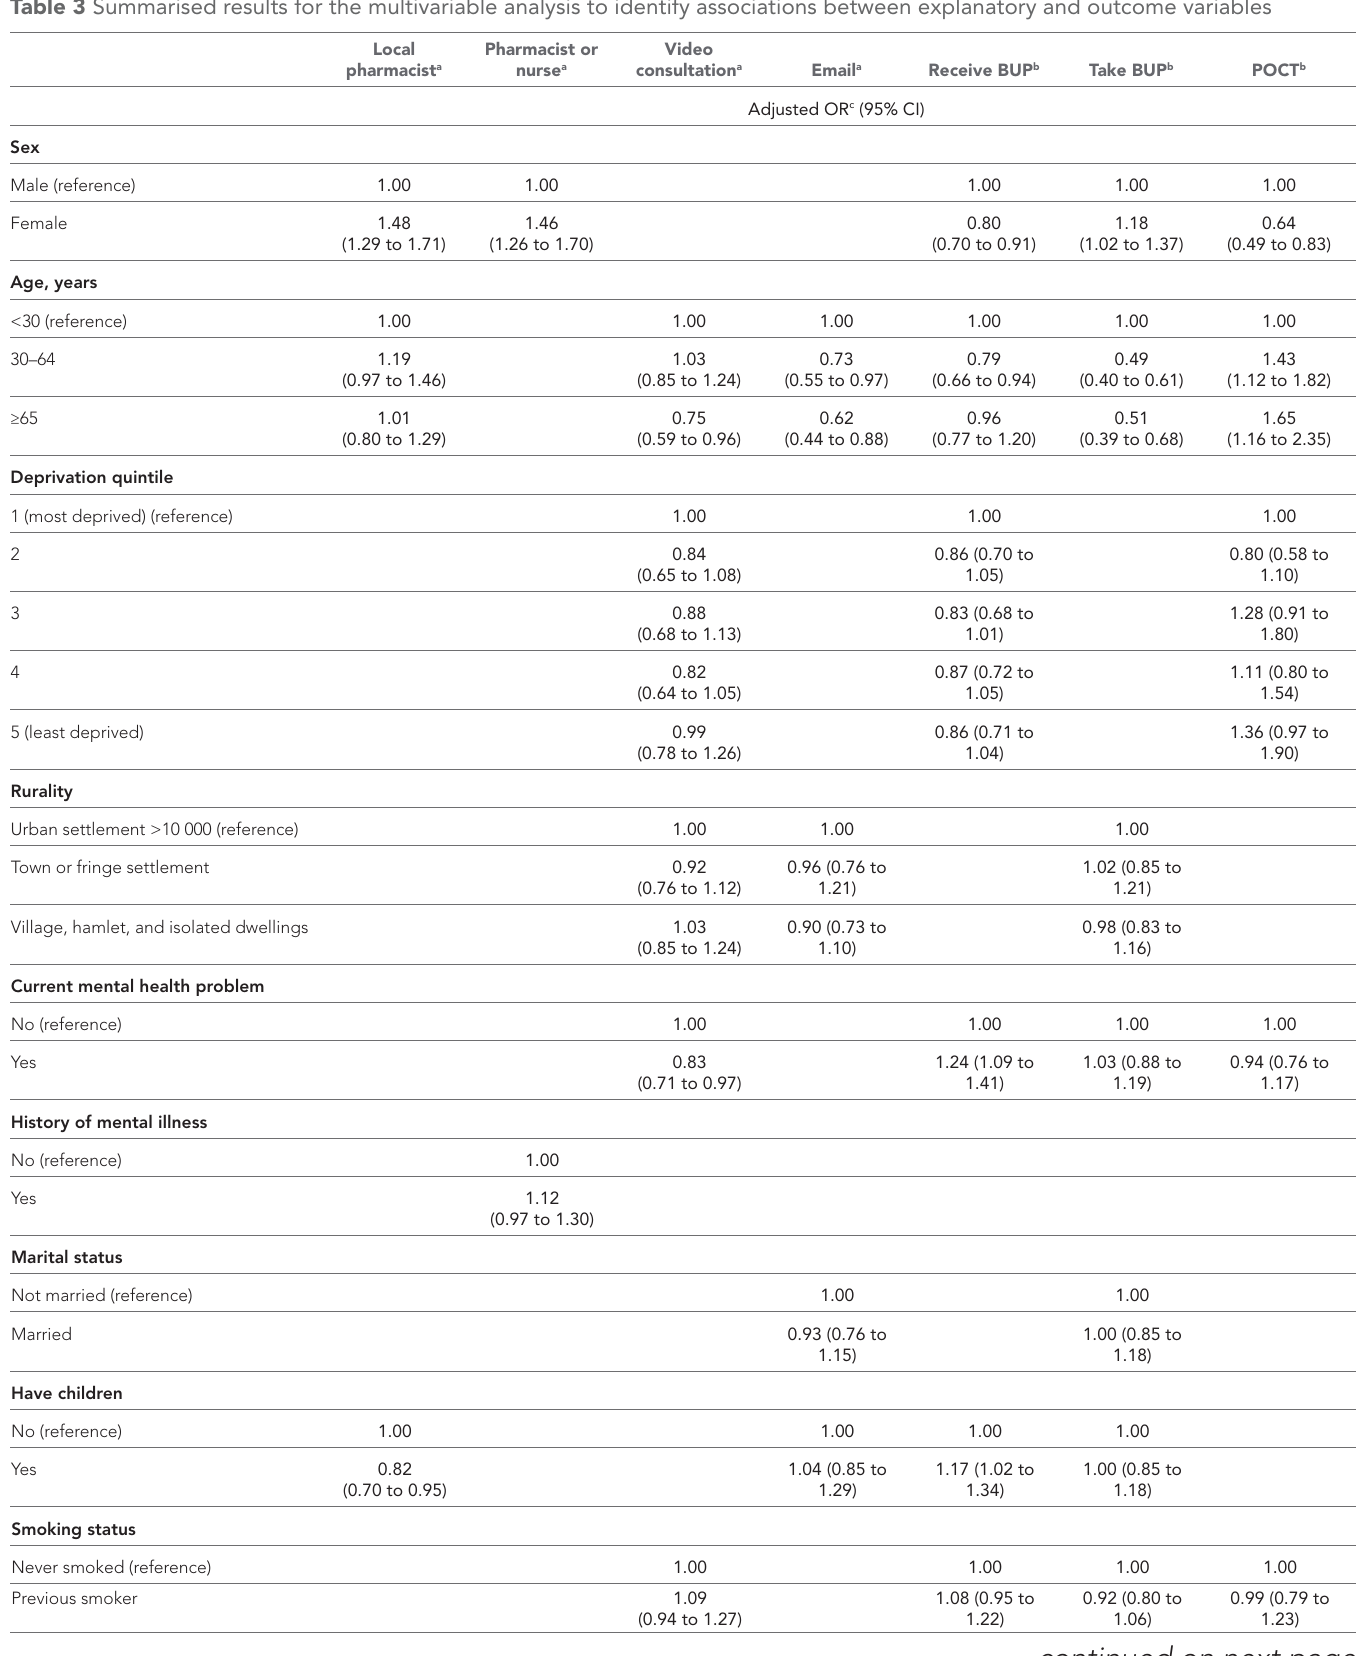
Table 3 Summarised results for the multivariable analysis to identify associations between explanatory and outcome variables Local pharmacist